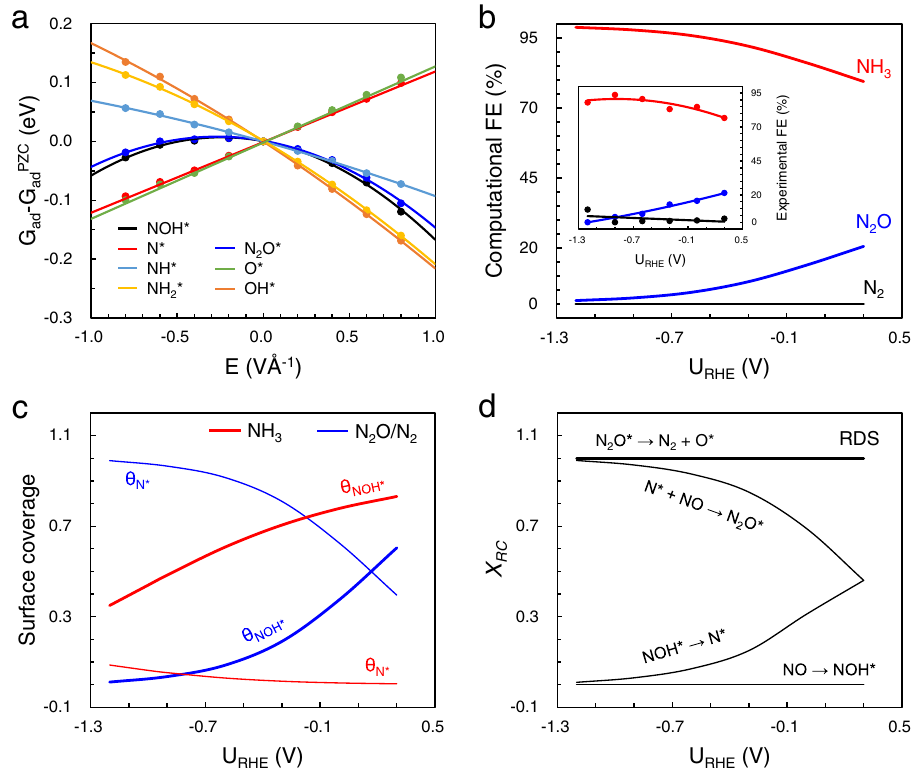
Fig. 7 | The results of microkinetic modeling on Cu. a Field effect on the adsorption energies of relevant intermediates in eNORR on Cu. b The computa- tional and experimental (insert) 19 FE of different products for eNORR on Cu. c The surfacecoverage of keyintermediates inthe formationof NH 3 (redlines)and dual-